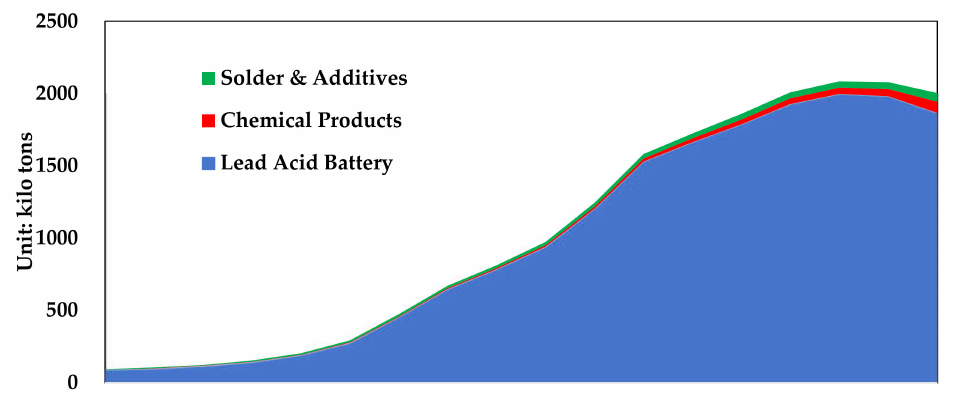
Figure 8. China’s recycled lead waste in 2000–2017. (Data source: